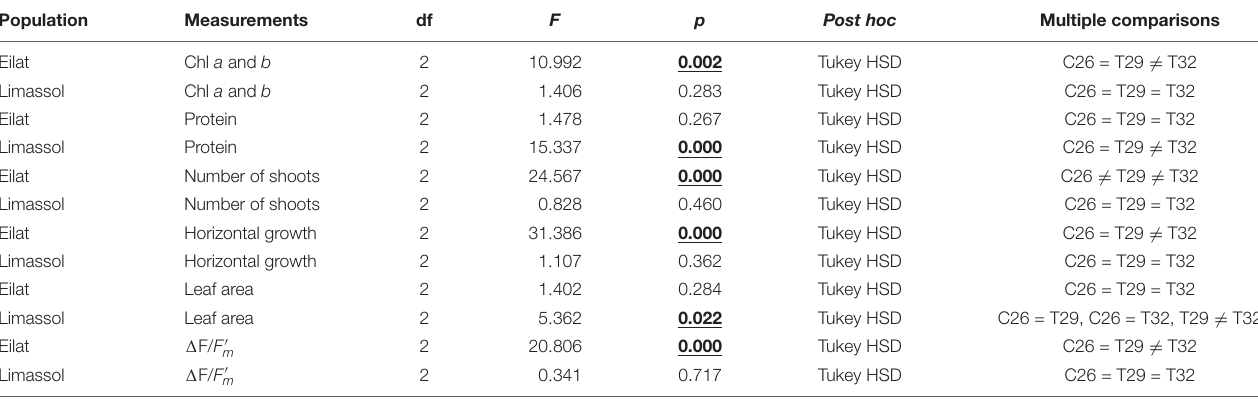
FIGURE 4 | Effects of a simulated heat wave on plant performance of native (A,C,E) vs. invasive (B,D,F) populations of H. stipulacea . Shown are changes over time (days of experiment) in the (A,B ) number of shoots (shoot plant − 1 ), (C,D) horizontal growth rates (mm week − 1 ) and (E,F ) leaf area (cm 2 ). In all parameters, results represent n = 5, mean ± SE. Gradient color bars indicate the experimental heat wave. TABLE 2 | GLM-repeated measures analyses and Multiple comparisons with Tukey HSD post hoc results from different populations (Eilat vs.